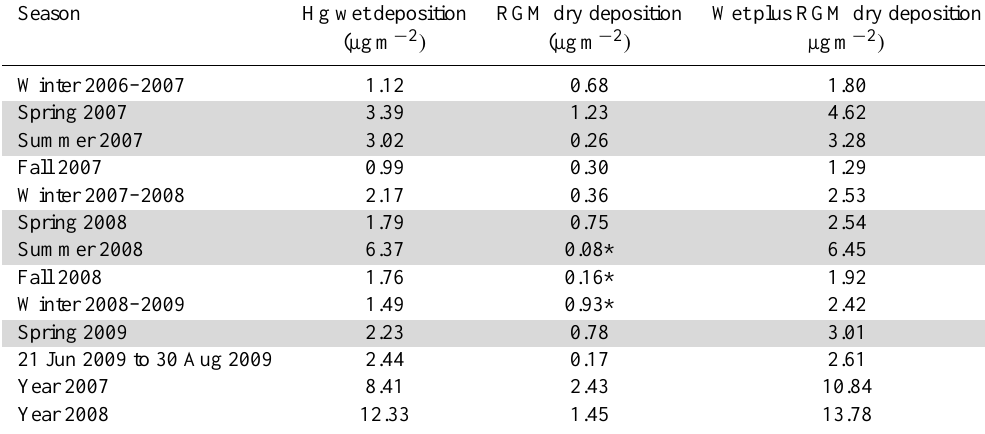
Table 3. Seasonal and annual Hg wet deposition and estimated RGM dry deposition fluxes, and the sum of Hg wet deposition and estimated RGM dry deposition at TF. The asterisks indicate seasons missing more than 3 days of RGM measurements. The seasonal daily average RGM was used to fill gaps in the data and calculate a total RGM flux. Spring and summer are shaded for easier visual comparison by season.